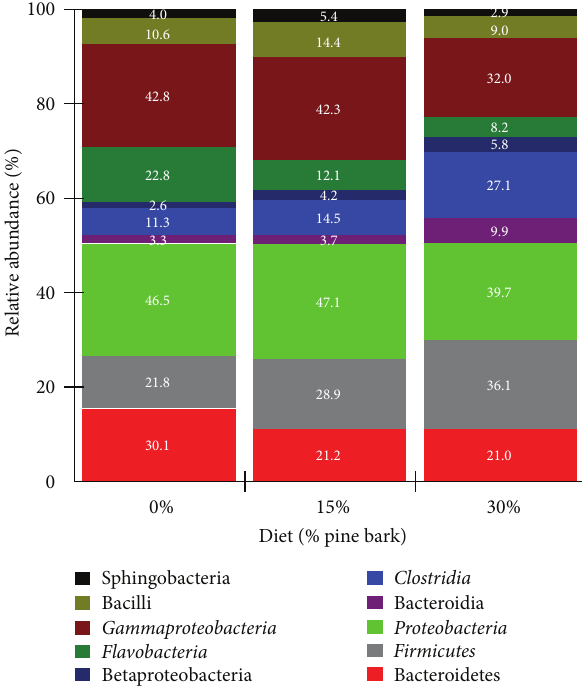
Figure 3: Relative abundance of major taxonomic groups across pine bark (PB) dietary supplementation in growing meat goats. Phyla included in this figure had relative abundance values consis- tently greater than 1%, as well as the abundant classes of the phylum Proteobacteria. Values presented are the mean percentage. 0% = 0% PB (control), 15% = 15% PB, and 30% = 30% PB on an as-fed basis.